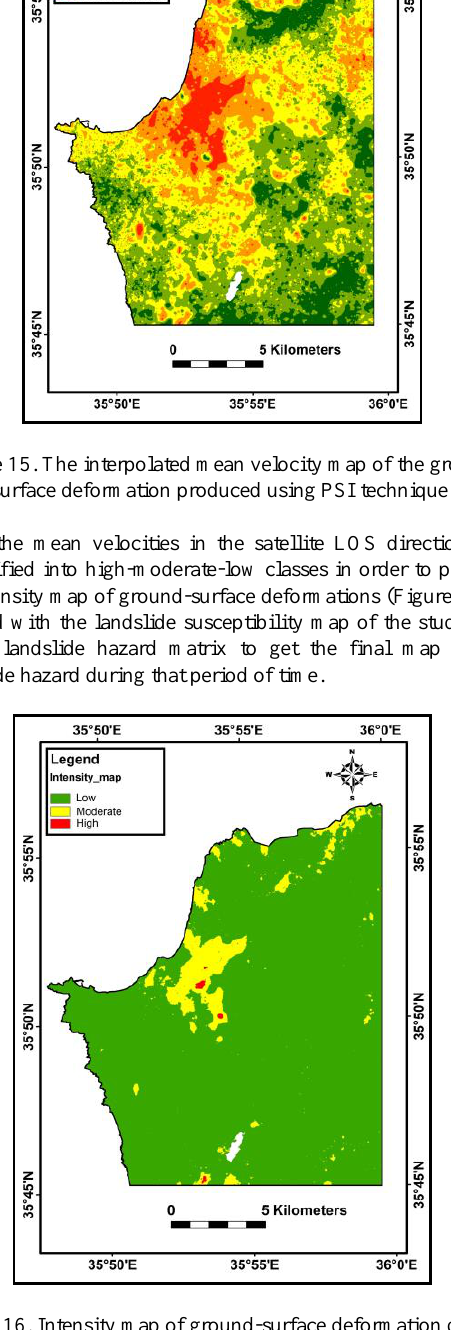
Figure 16. Intensity map of ground-surface deformation during the period from 16 October 2018 until 21 March